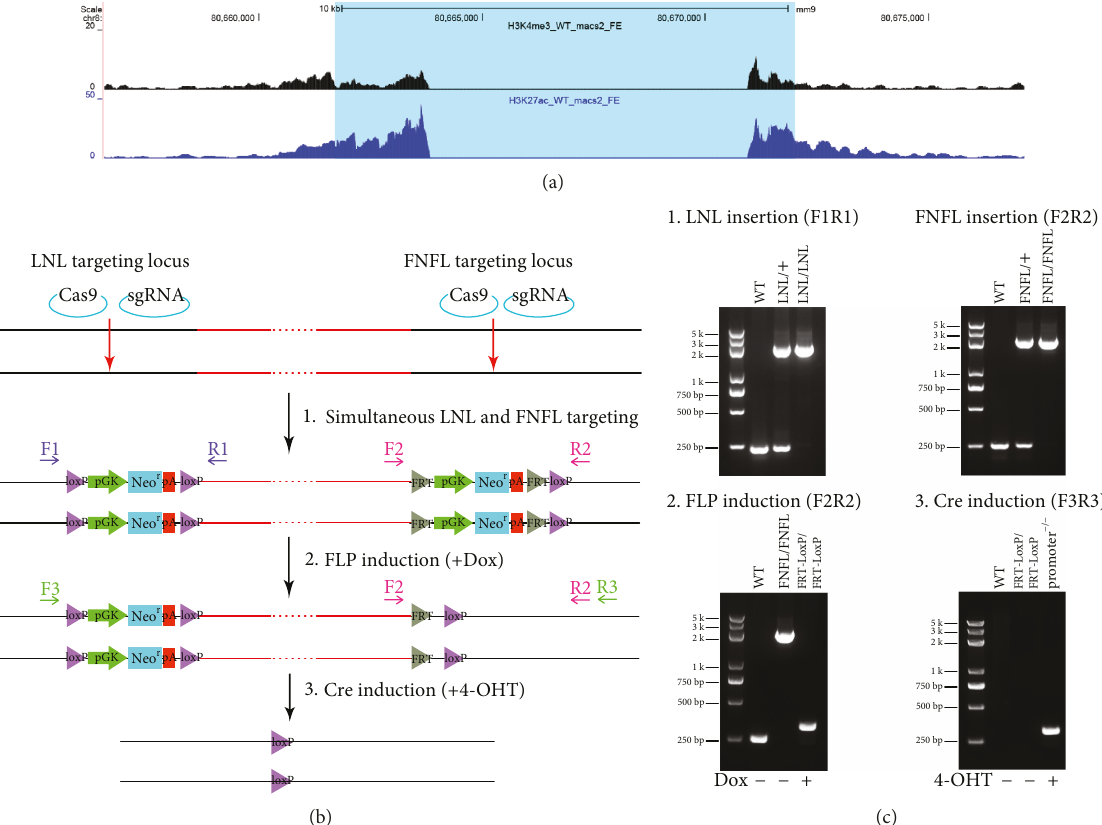
Figure 5: Generation of conditional knockout of one putative regulatory region through a one-step targeting strategy. (a) The 10 kb region is identi fi ed as a putative regulatory element based on the H3K27ac and H3K4me3 ChIP-seq data of wild-type mESCs using H3K27ac and H3K4me3 antibodies. H3K4me3 and H3K27ac modi fi cations are shown by black and blue peaks, respectively. (b) Schematics of simultaneous LNL and FNFL targeting to the 10kb regulatory region in one step. The CRISPR targeting sites for the insertion of LNL and FNFL cassettes are labelled by red arrows. (c) Genotyping results of the 10 kb putative regulatory region with simultaneous targeting of LNL and FNFL cassettes. In clones with biallelic insertion of LNL cassettes, the PCR amplicon change from the 237bp wild-type allele to the 2.1 kb targeting allele using primers F1 and R1 was detected (c1). Besides, a 2.15kb amplicon was obtained in FNFL biallelic insertion clones using primers F2 and R2, without detecting the 251 bp wild-type allele (c1). Then, the removal of FNFL cassettes upon Dox addition was identi fi ed by the amplication of the 325bp DNA fragment using primers F2 and R2 (c2). Furthermore, external primers F3 and R3 ampli fi ed a 863bp DNA fragment which could only be ampli fi ed when the 10kb regulatory region was deleted